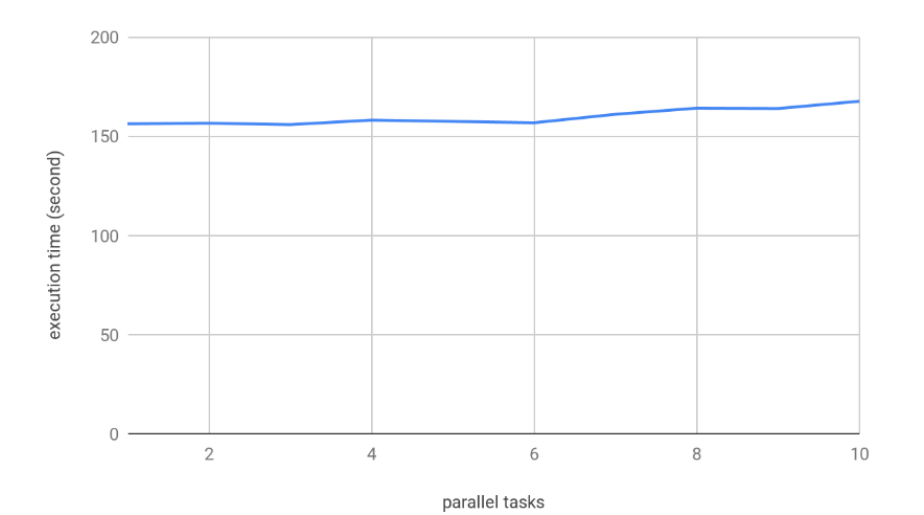
Figure 10. Execution time for multiple parallel